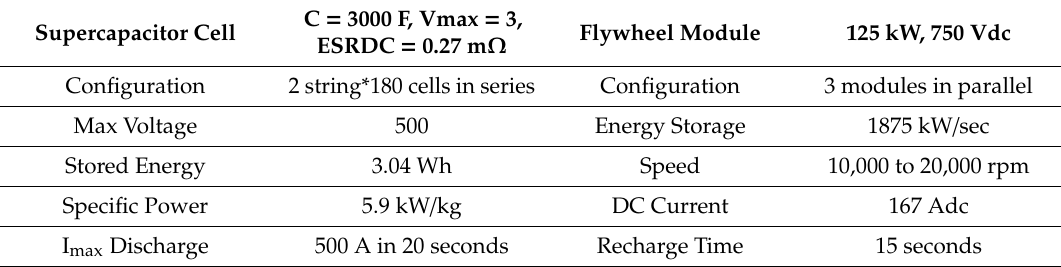
Figure 11. Substation B power profile. Table 4. FESS and SESS sizing